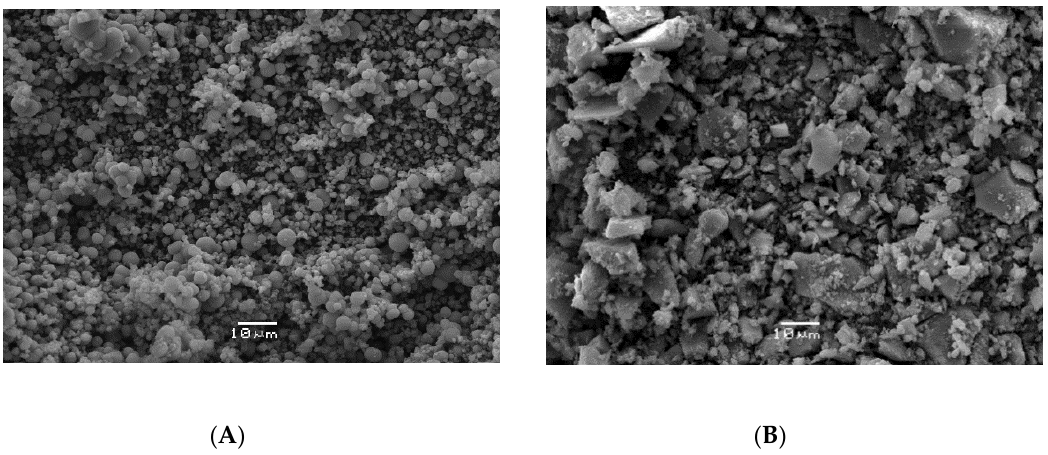
Figure 4. Transmission electron microscopy (TEM) images of ( A ) material (MT1) and ( B ) MT2.